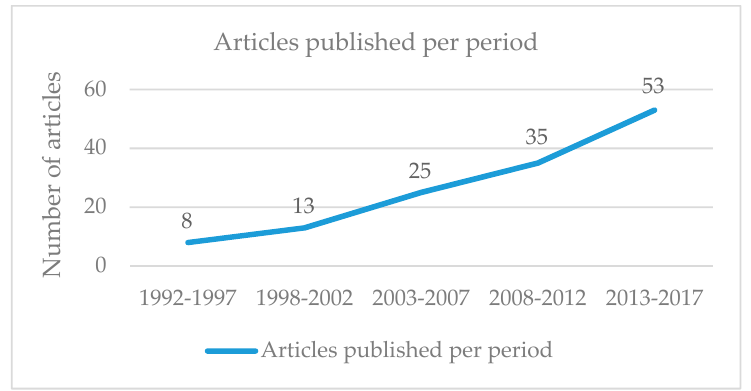
Figure 1. Number of articles published.